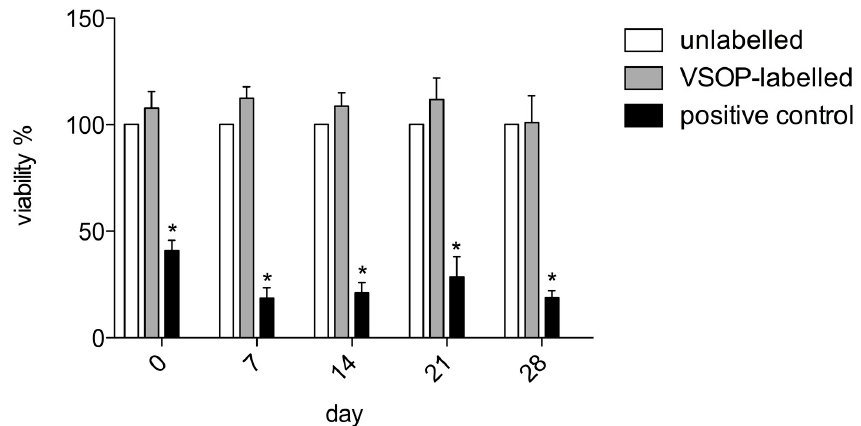
Figure 4. The MTT test was used to assess the influence of the labelling procedure on the proliferation of hASCs and cytotoxic effects. There was no difference between the viability of VSOPs-labelled (light grey columns) and unlabelled cells (white columns) 24 h, 7 days, 14 days, 21 days and 28 days after the labelling procedure. Mean extinction values were averaged from 8 wells per patient and group and normalized to the respective values of unlabelled hASCs from the same patient. The value of the unlabelled hASCs was normalized to a viability of 100% per patient. Human ASCs treated with Luperox ® served as positive controls (black columns) and showed a significant decrease in cell viability compared to labelled and unlabelled cells. Significance is indicated by asterisks (* p <